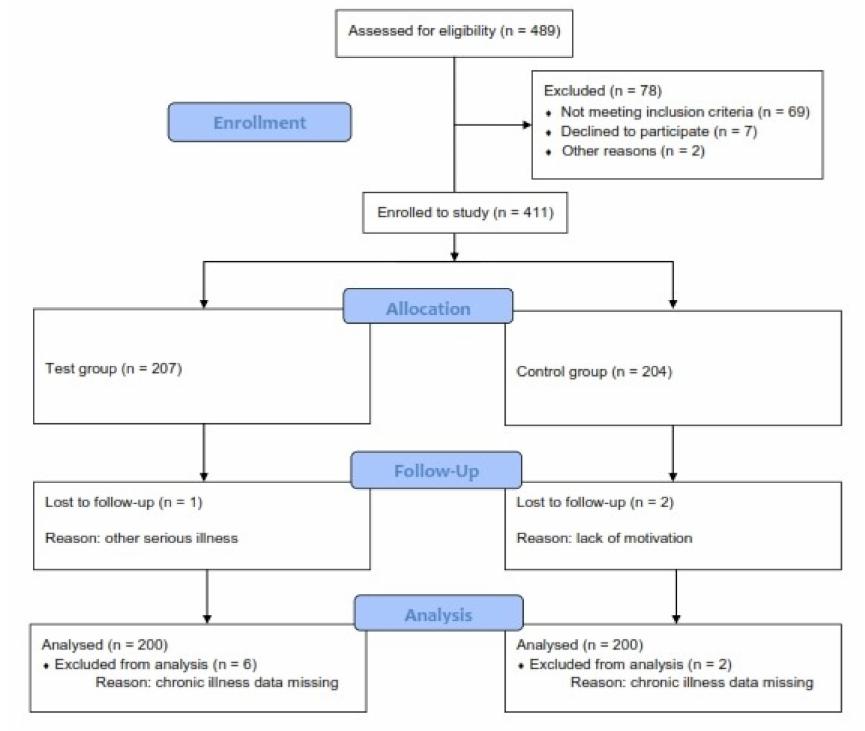
Figure 1. Study flow